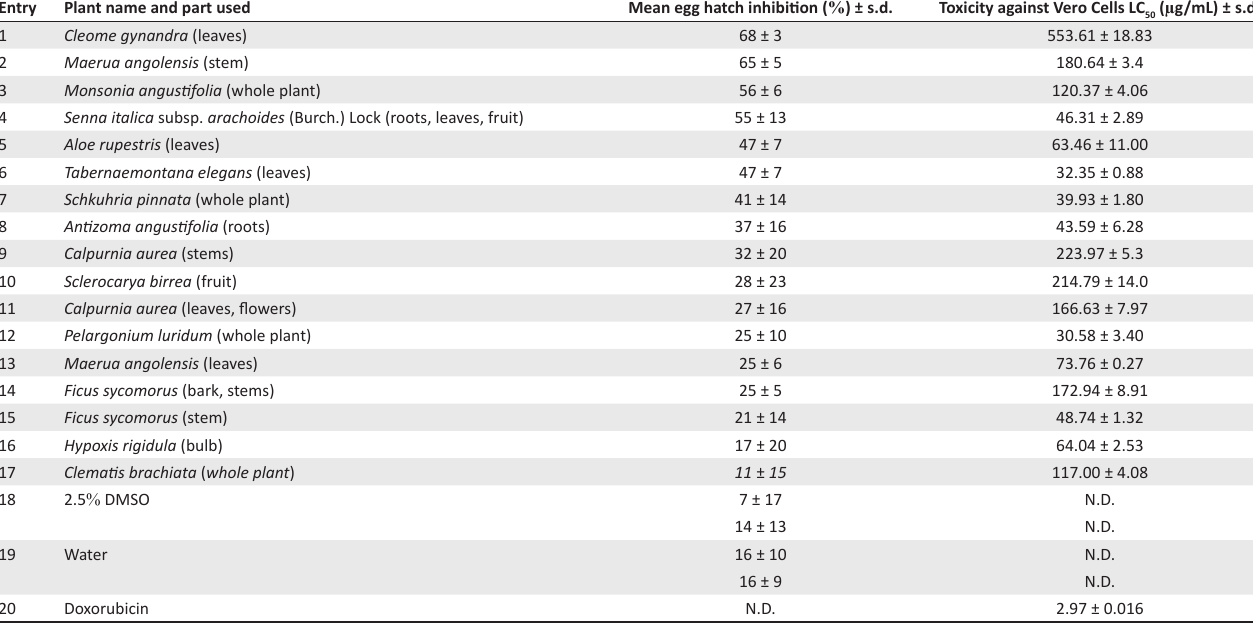
TABLE 2: Mean inhibition percentages of the acetone extracts (2.5 mg/mL) on egg hatching of Haemonchus contortus from sheep and the toxicity values (LC against Vero cells.